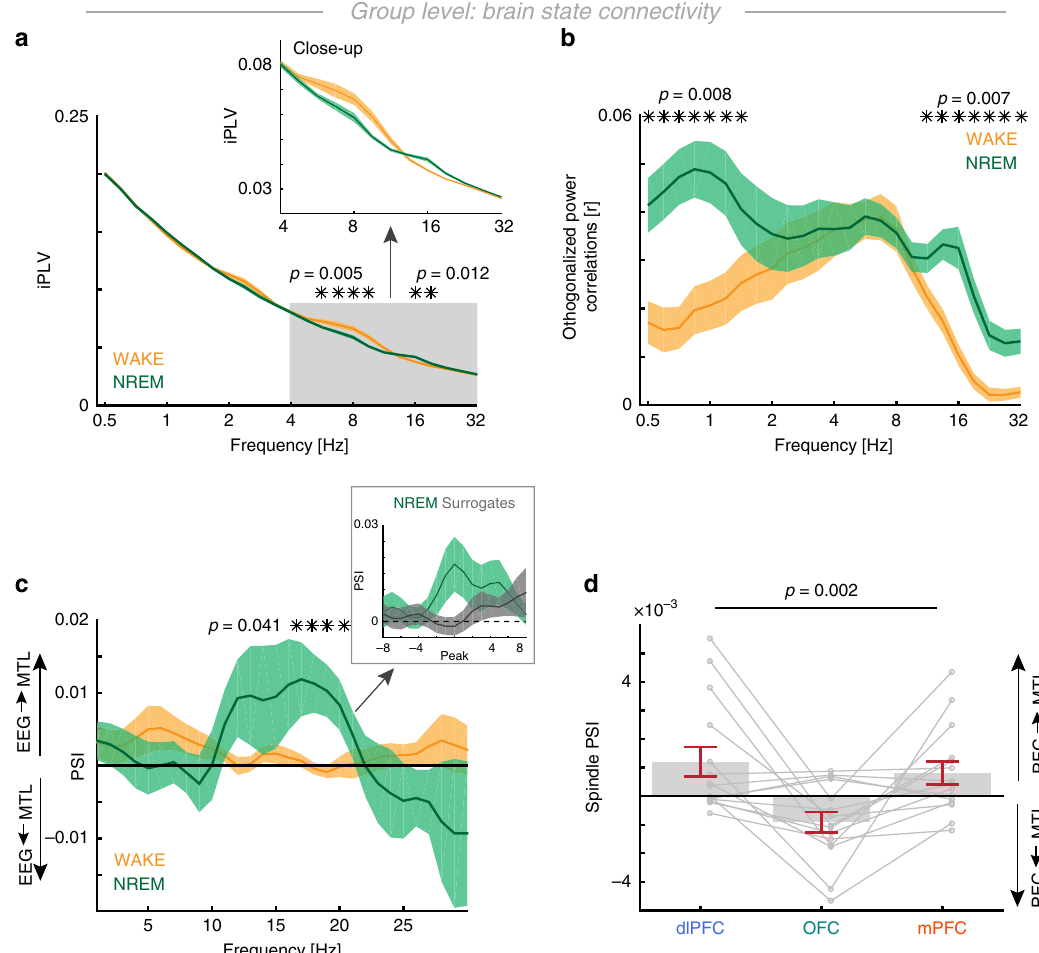
Fig. 5 PFC-MTL connectivity and directionality. a Phase locking analyses revealed increased spindle phase coupling during NREM sleep (cluster tests: p = 0.0120, d = 1.37), but no elevated SO synchrony ( p = 0.3087, d = 0.69). During wakefulness, we observed enhanced alpha-band coupling ( p = 0.005, d = 0.83). b Power correlations (mean ± SEM) between scalp EEG and hippocampus revealed differences in amplitude couplings during NREM sleep (SO cluster: p = 0.0080, d = 1.07; spindle cluster: p = 0.0070, d = 1.20). c State-dependent directionality analysis indicates signi fi cant EEG to MTL in fl